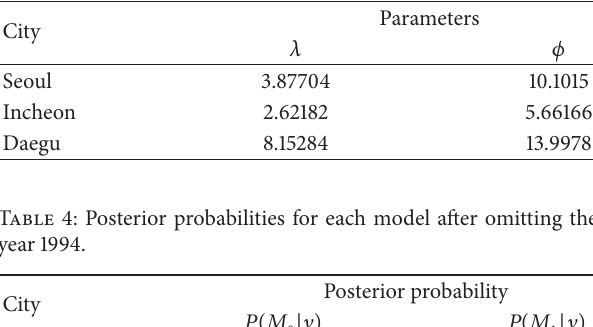
Table 3: Bayes estimates for parameters 𝜆 and 𝜙 .